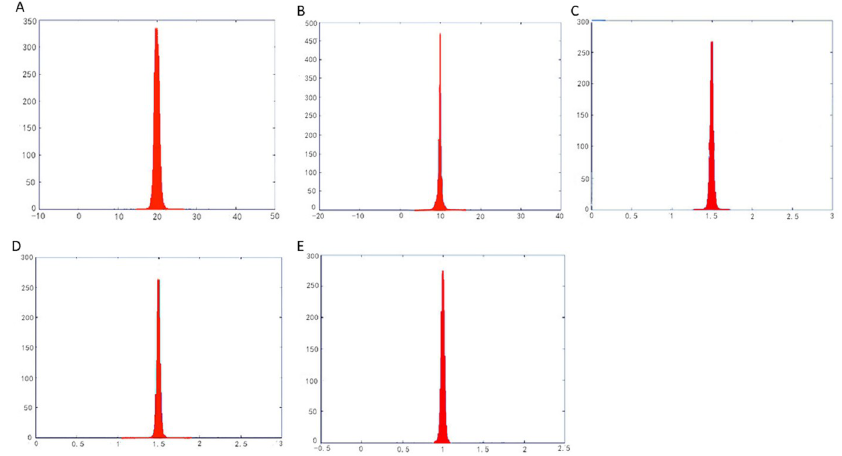
Fig 11. Histograms of area distortions on the balls model. (A) result by LABF, (B) result by LQHP, (C) result by IQCP, (D) result by QCTM, (E) result by our method.